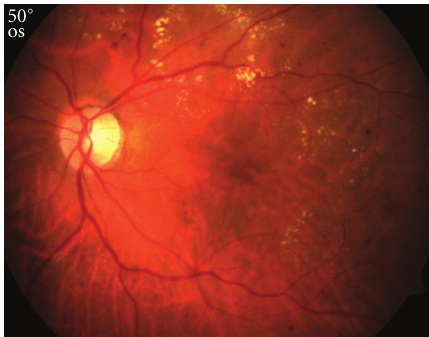
Figure 1: Fundus photograph of the left eye from a patient with severe NPDR and CSME.